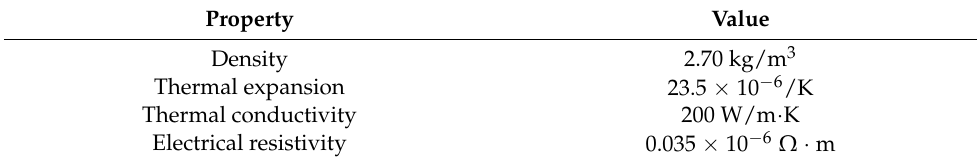
Table 2. Physical properties of the aluminum alloy 6063.